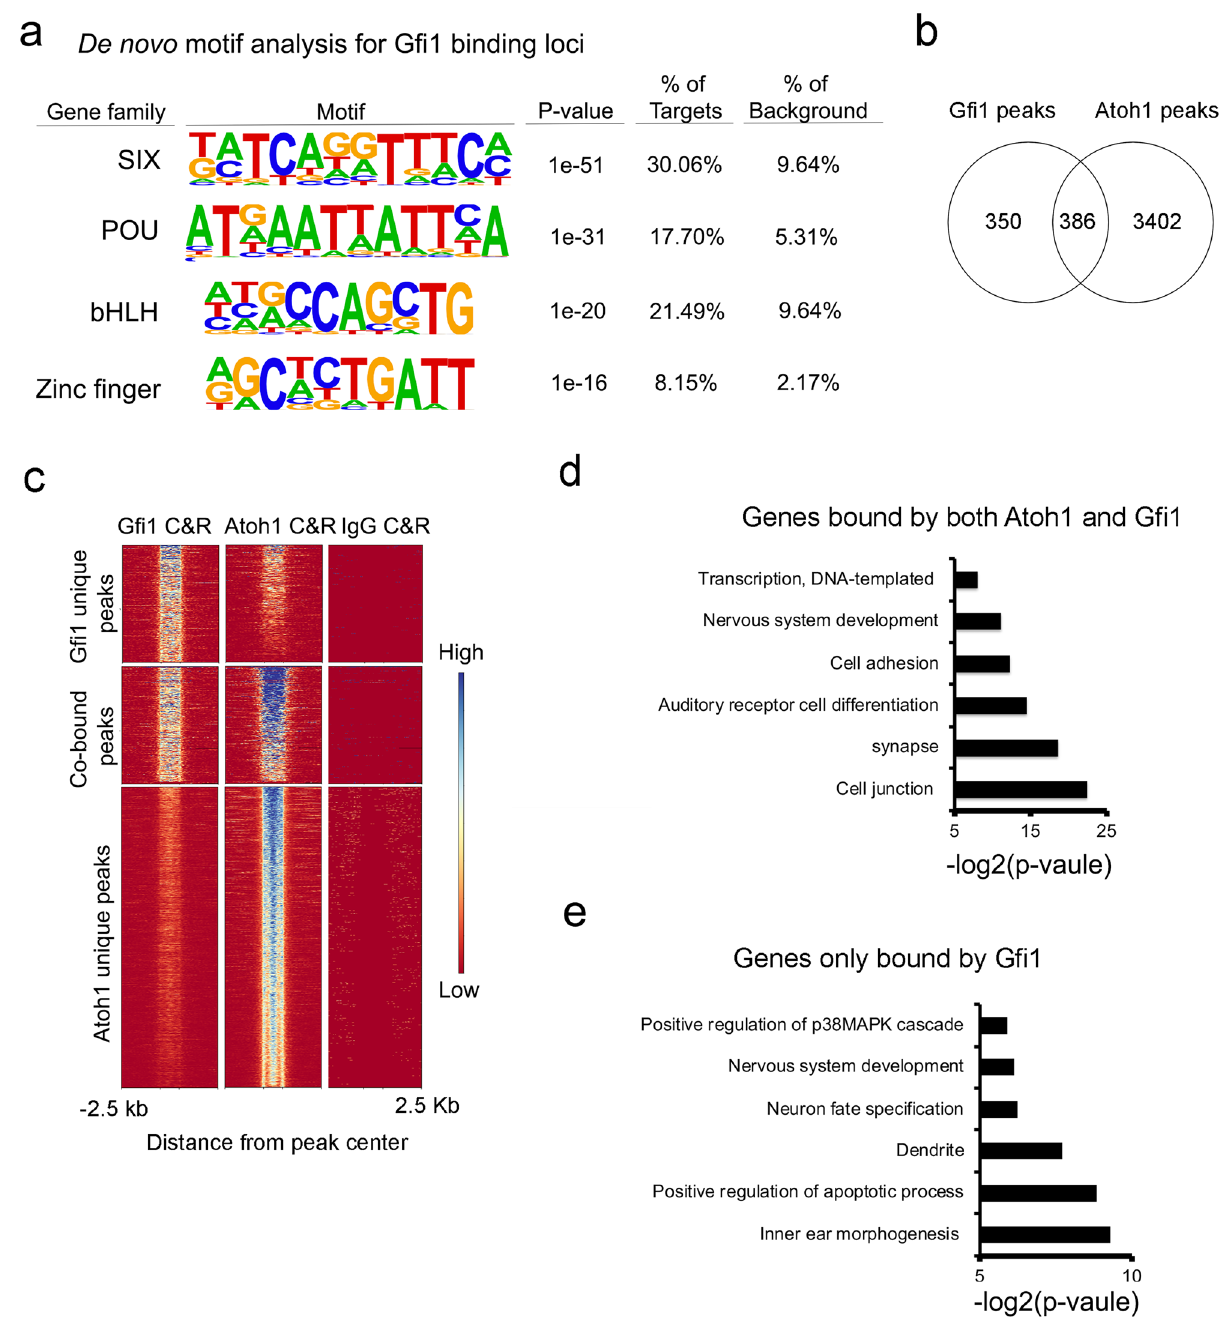
Figure 3. GFI1 and ATOH1 bind to many common genomic sites in hair cells. ( a ) De novo motif analysis of 732 GFI1 binding loci. Of note, the most significantly enriched motifs in the GFI1-bound peaks are for SIX, POU and bHLH protein families, with zinc finger family protein motifs (of which GFI1 is a member) are only found in 8.15% of targets. ( b ) Venn diagram of the peaks obtained in CUT&RUN experiments for GFI1 and ATOH1 binding, showing 386 overlapping loci that are bound by both GFI1 and ATOH1. ( c ) Heat map showing individual called peaks from GFI1 and ATOH1 CUT&RUN analysis shown in B. ( d ) Gene ontology analysis of and the 341 ATOH1 and GFI1 co-bind genes. ( e ) Gene ontology analysis of the 309 GFI1 uniquely binding